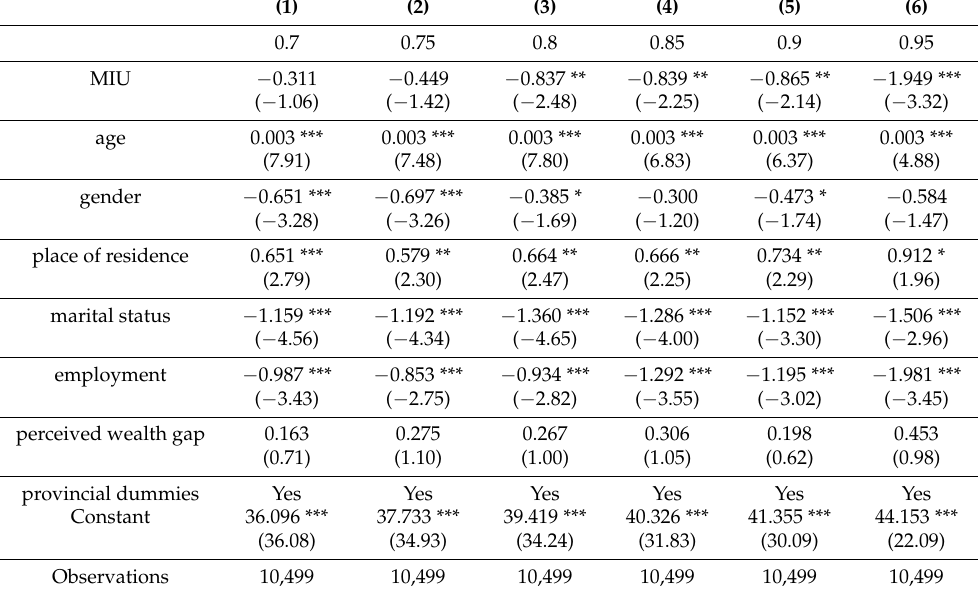
Table 6. Quantile regression 2.